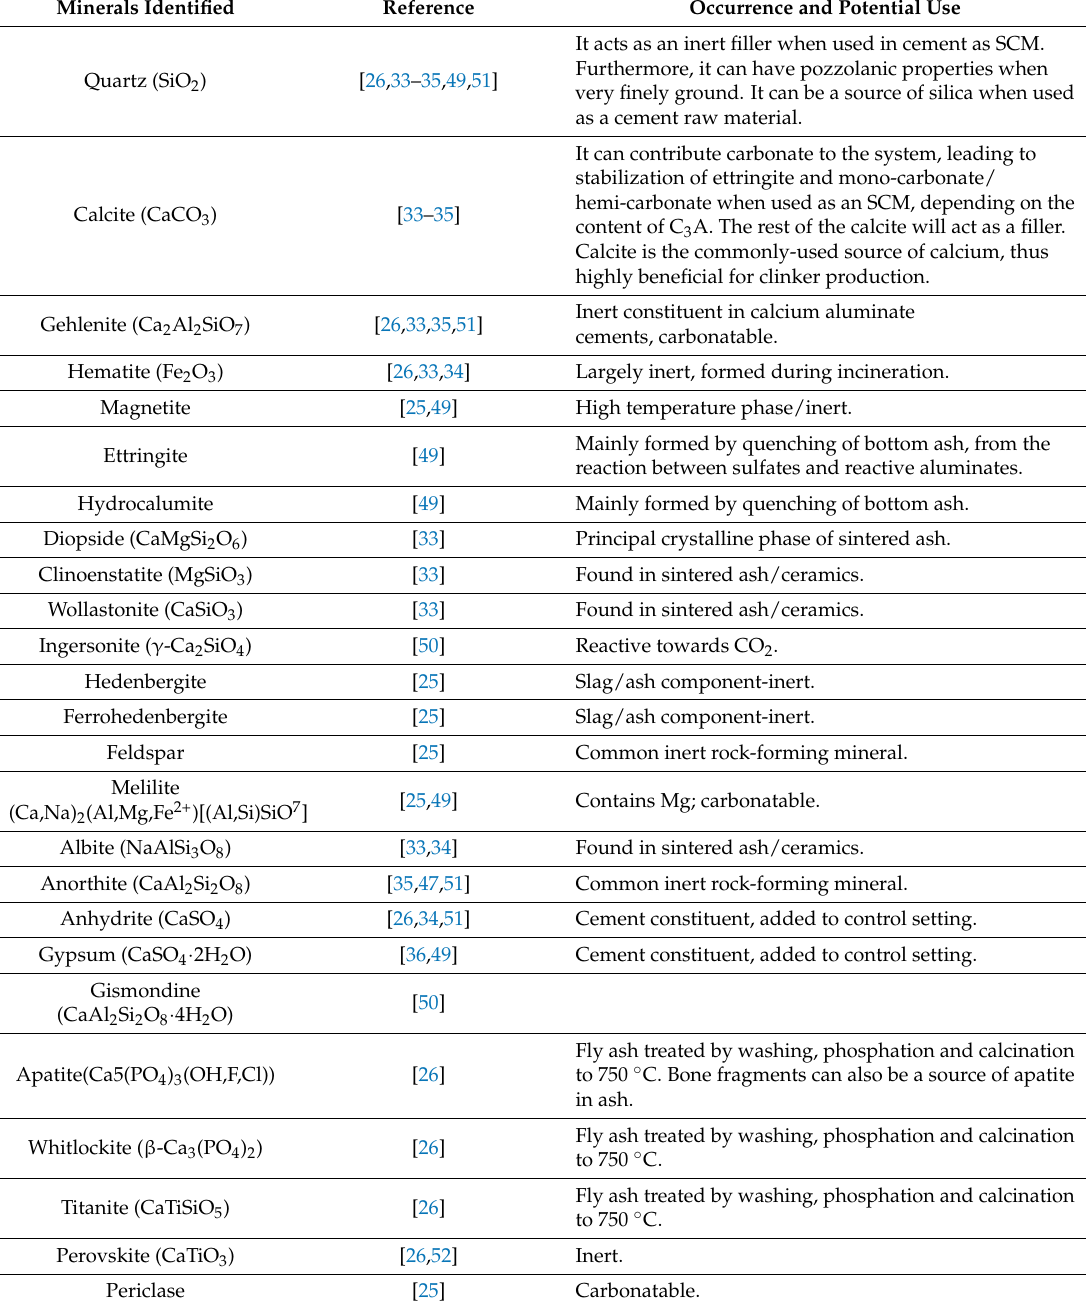
Table 2. Mineralogy of bottom ashes, fly ashes and sintered ashes from MSWI